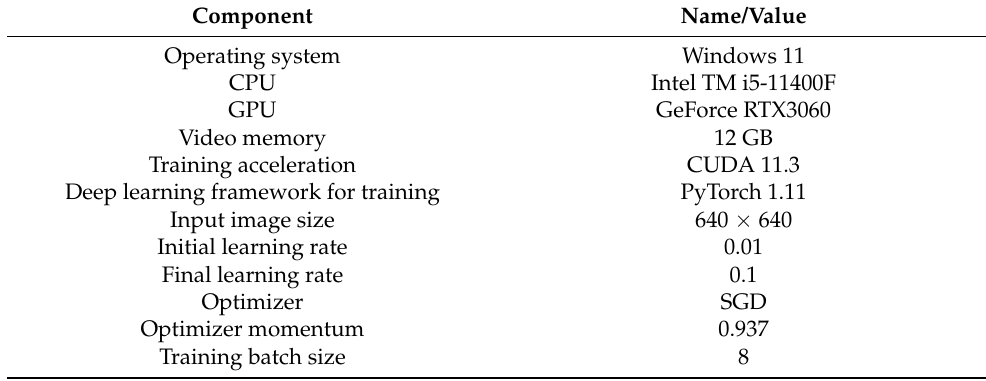
Table 2. Experiments setup